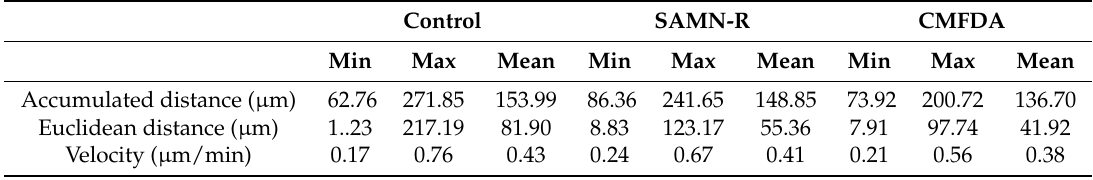
Table 3. Migration of hMSCs in Patient 1 from 18 cells of control, CellTracker™ Green CMFDA (5-chloromethylfluorescein diacetate) labelled, and rhodamine-derived superparamagnetic maghemite nanoparticles (SAMN-R) treatment groups. The velocity, accumulated, and Euclidean distance values for a six-hour period are